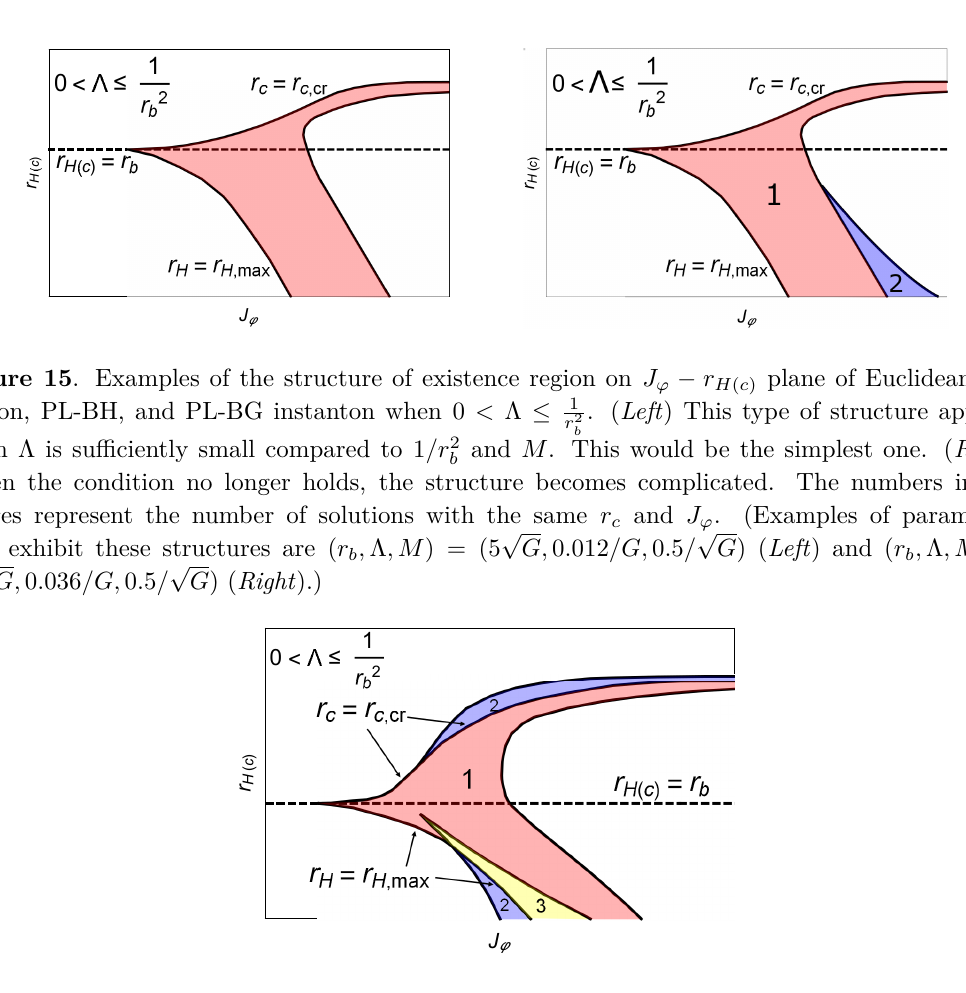
Figure 16 . Another example of the structure of existence region on J ϕ − r PL-soliton, PL-BH, and PL-BG instanton when 0 < Λ ≤ 1 exhibits this structure is ( r